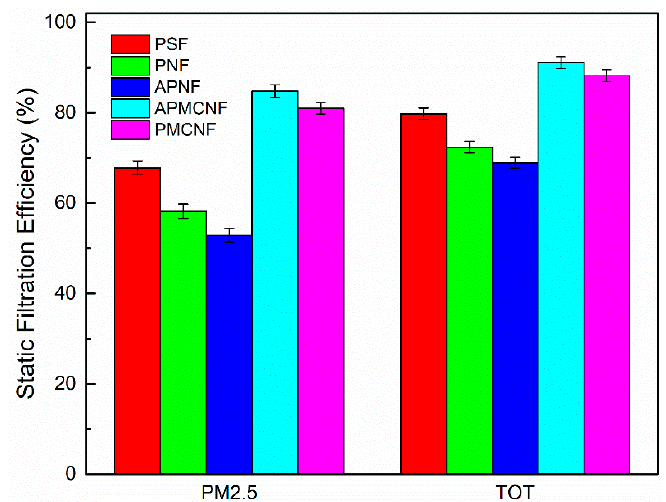
Figure 6. The static filtration efficiencies of the clean filter media for PM 2.5 and TOT at a filtration velocity of 1 m ∙ min − 1